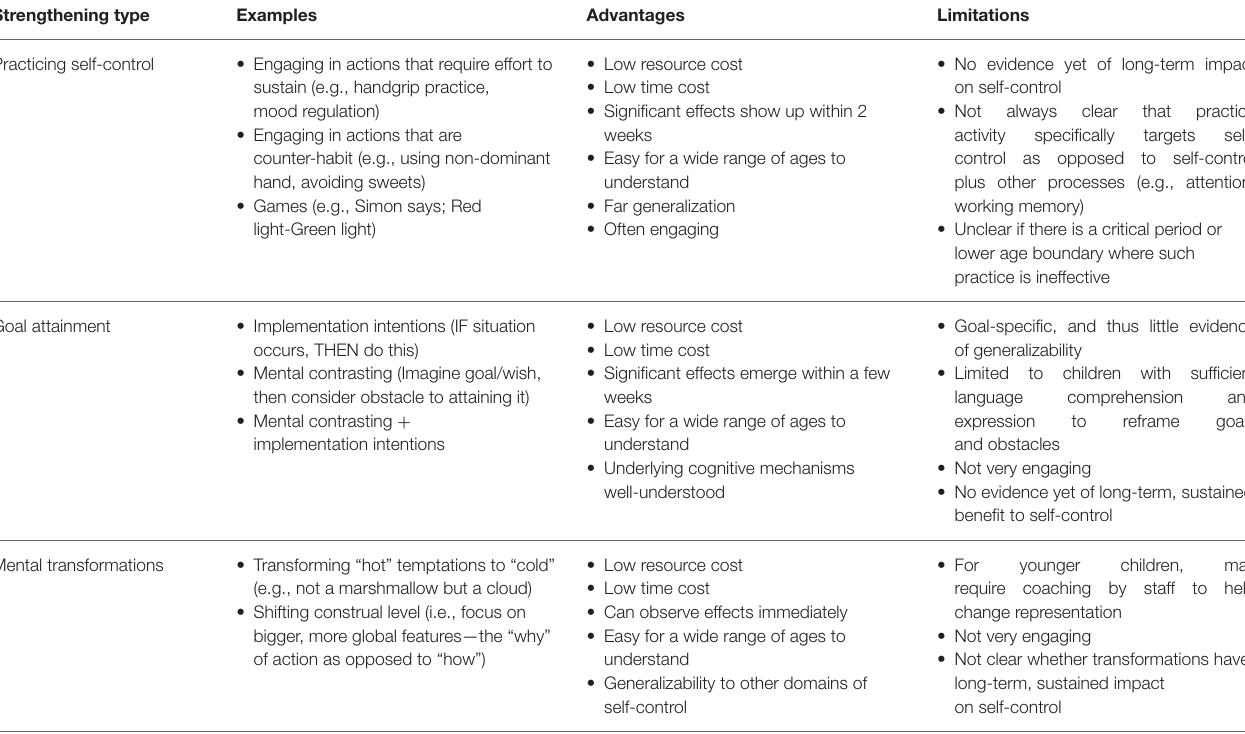
TABLE 2 | Different types of self-control strengthening